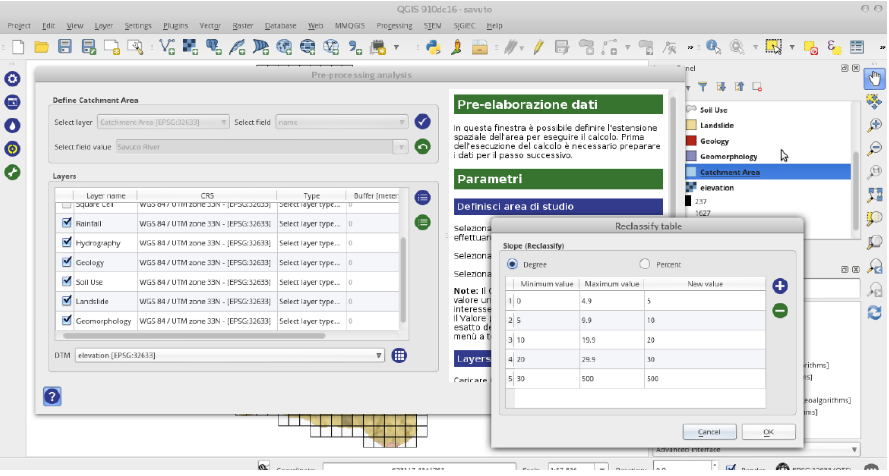
Figure 2. Graphical User Interface of stage 1 including the preprocessing dialog (on the left) and the dialog for the slope reclassify (on the right).